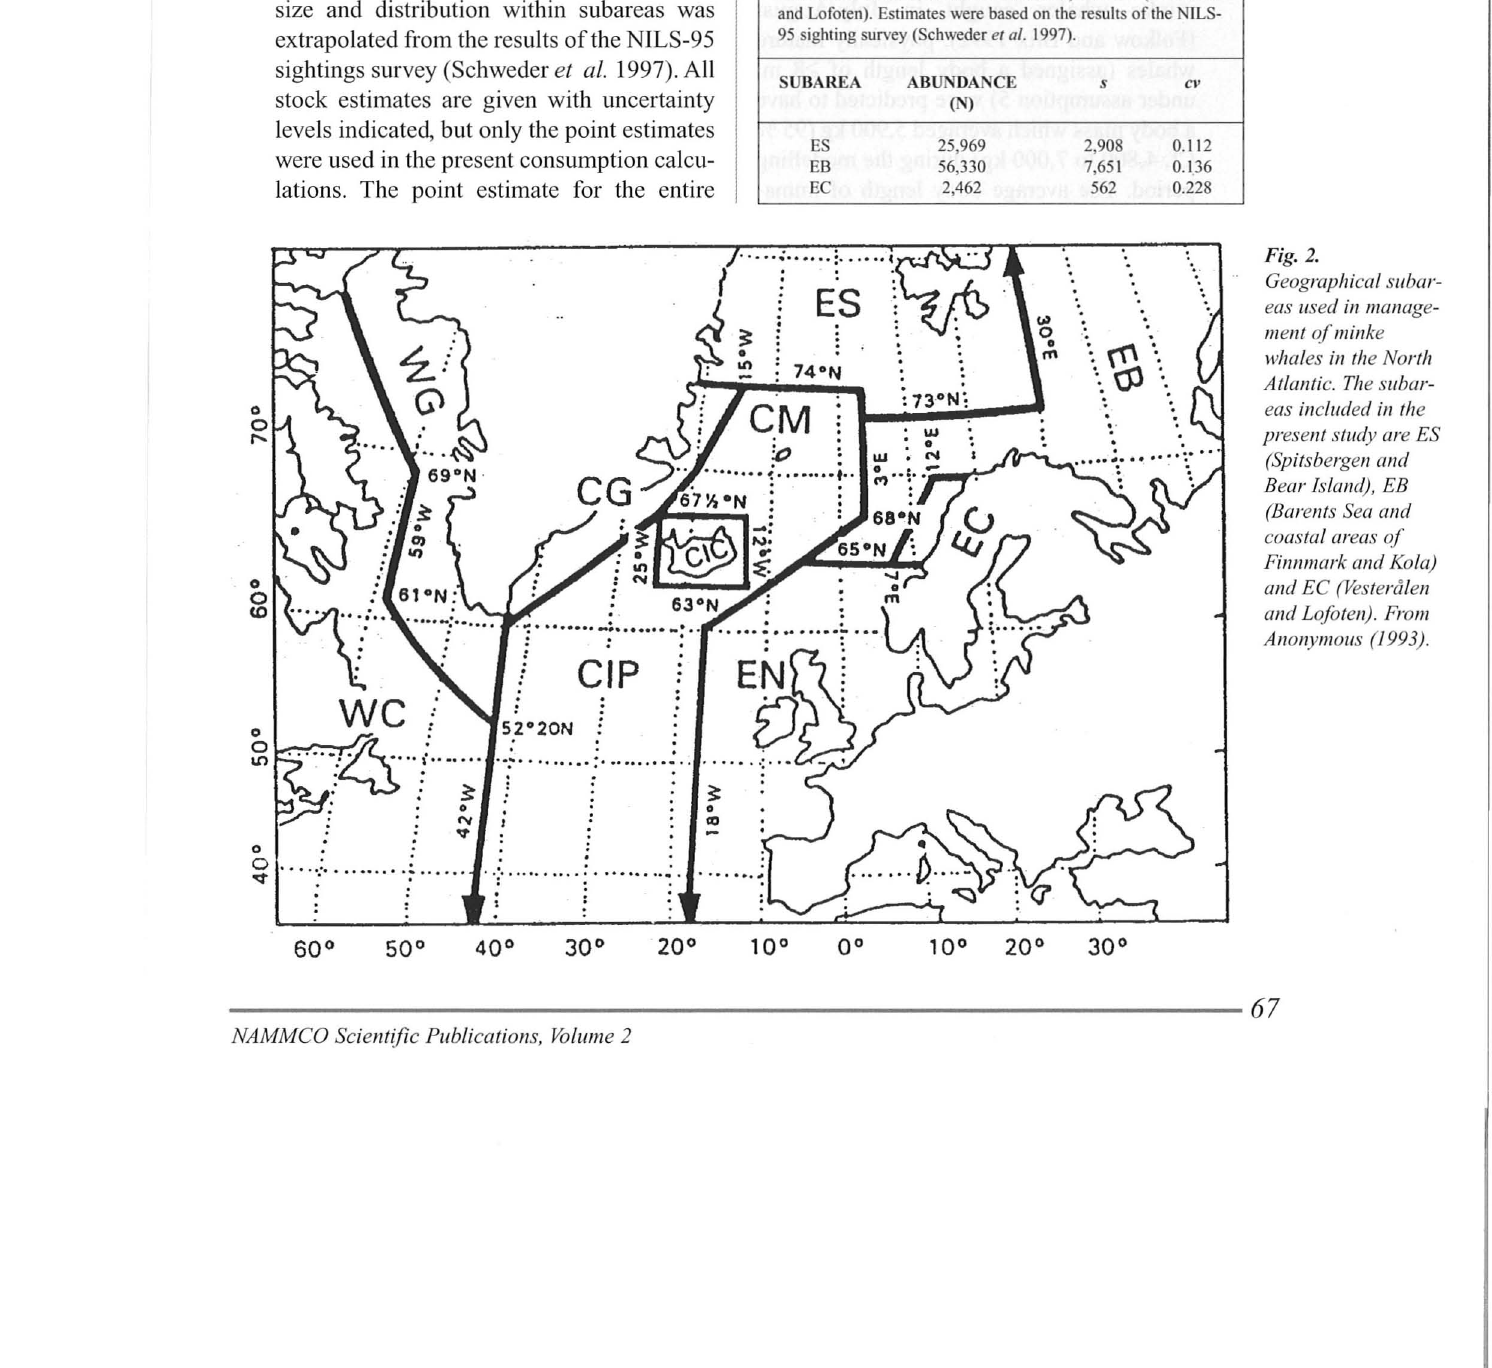
Table 1. Minke whale abundance estimates (N) with standard deviations (SD) and coefficients of variation (CV) for the three subareas ES (Spitsbergen and Bear Island), EB (Barents Sea and coastal areas of Finnmark and Kola) and EC (Vester:llen and Lofoten). Estimates were based on the results of the NILS- 95 sighting survey (Schweder et al. 1997). SUBAREA ES EB